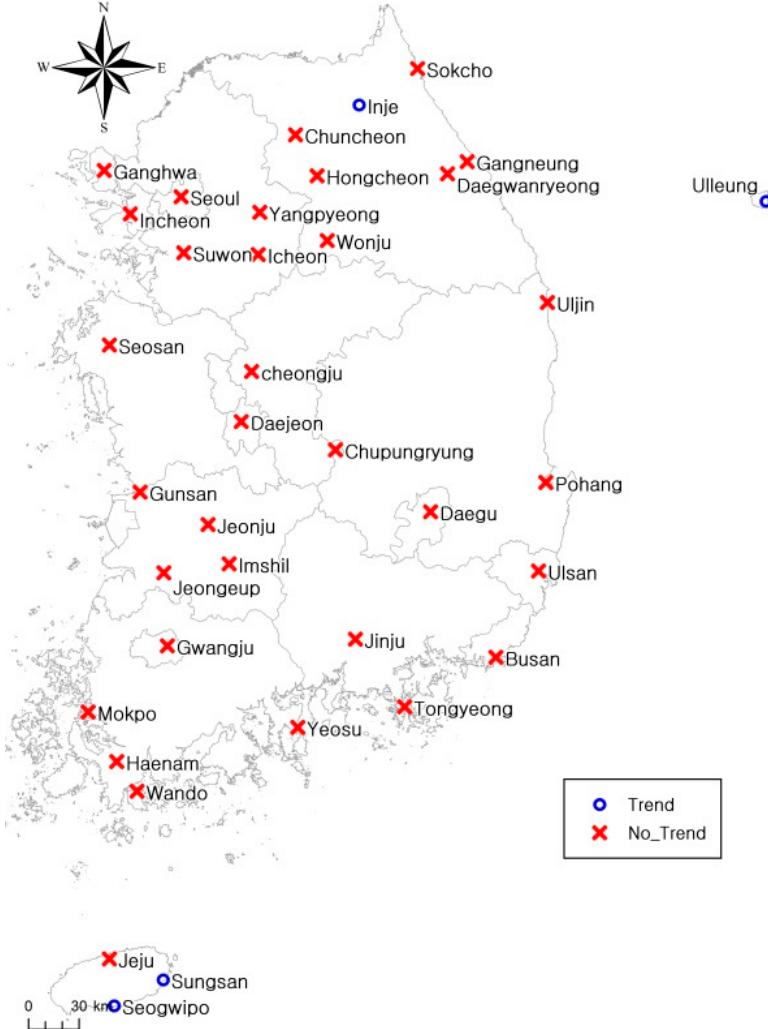
Figure 11. Trend analysis result for each station.